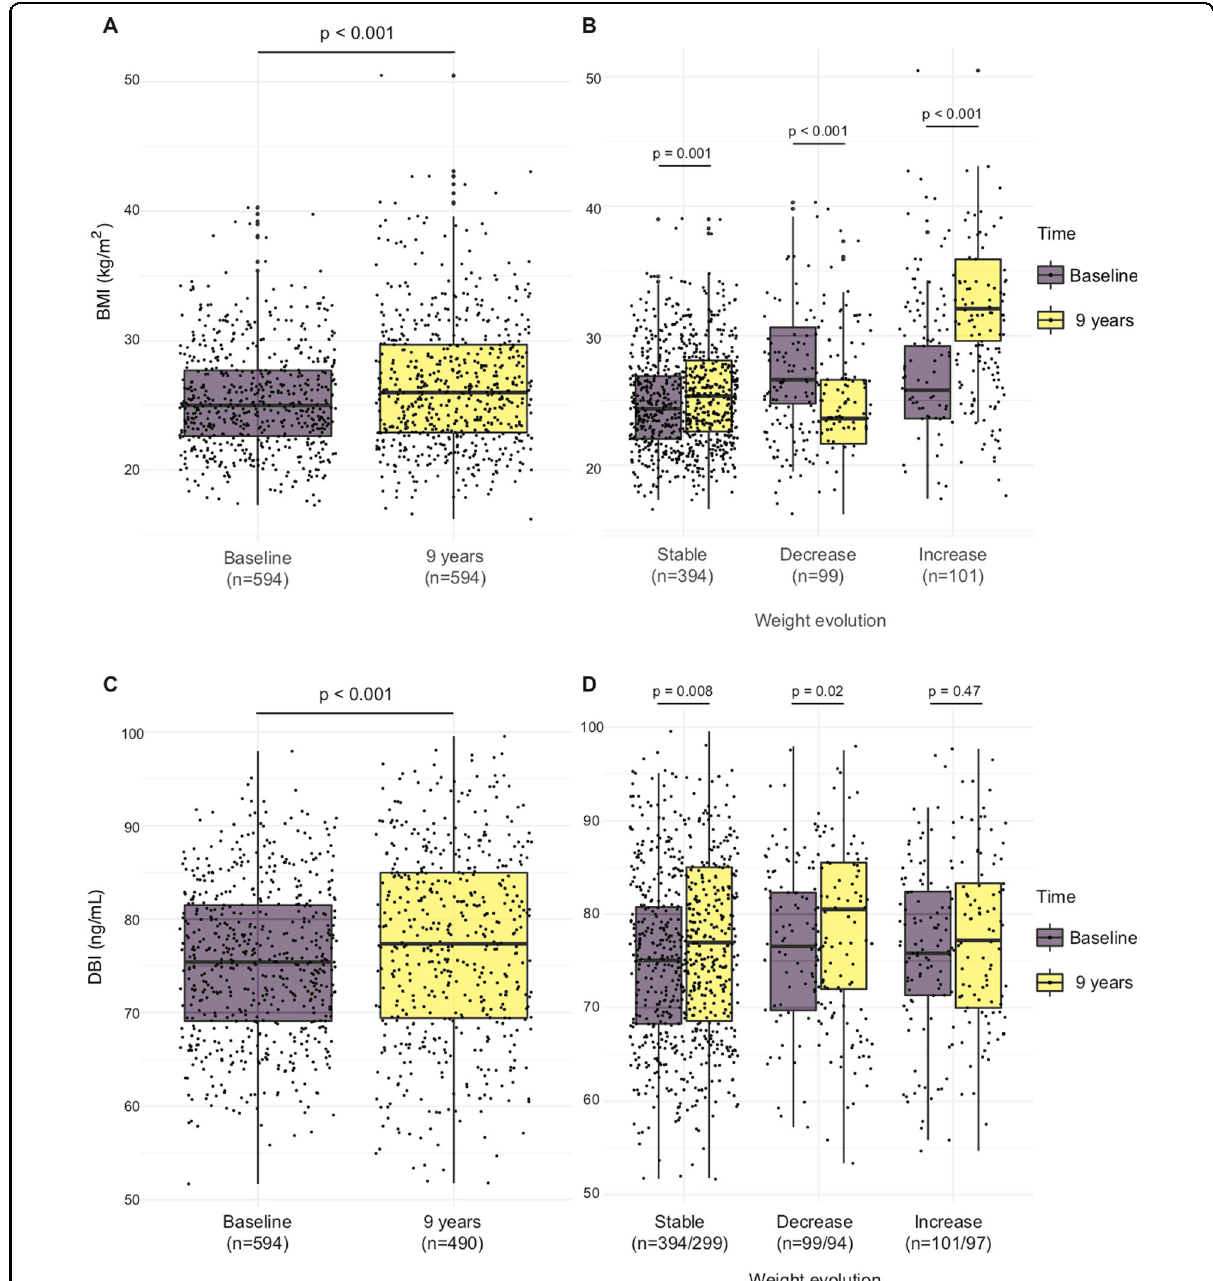
Fig. 2 Evolution of BMI and ACBP/DBI levels in individuals with decreasing, stable or increasing body weight. The evolution of BMI ( A , B ) and ACBP/DBI ( C , D ) is shown for individuals who gain weight, lose weight or whose weight remains stable over a 9-year period. Box and whisker plots representing BMI (kg/m 2 ) ( A , B ) and ACBP/DBI levels (ng/mL) ( C , D ) at baseline and 9 years later in the DESIR